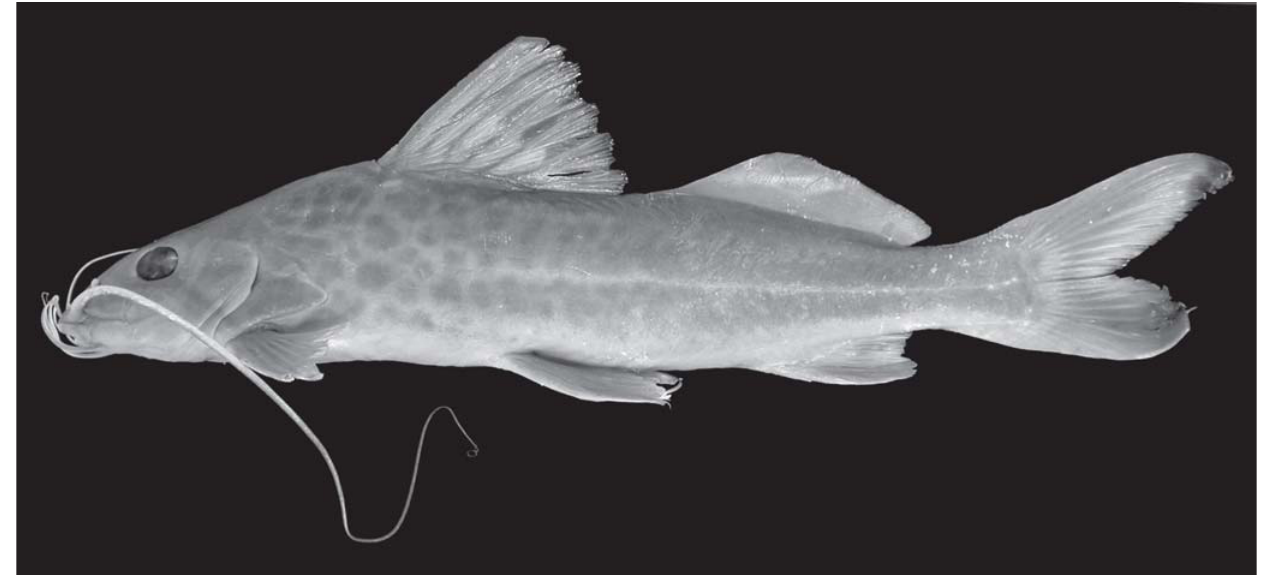
Fig. 3 . Pimelodus microstoma , MZUSP 23204, Jupiá dam, upper rio Paraná, 120.0 mm